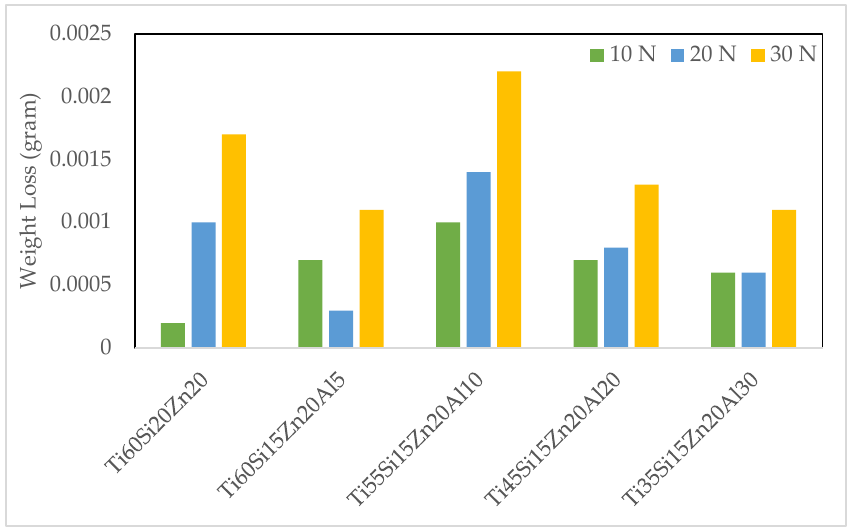
Figure 5. Weight losses of specimens according to wear loads.